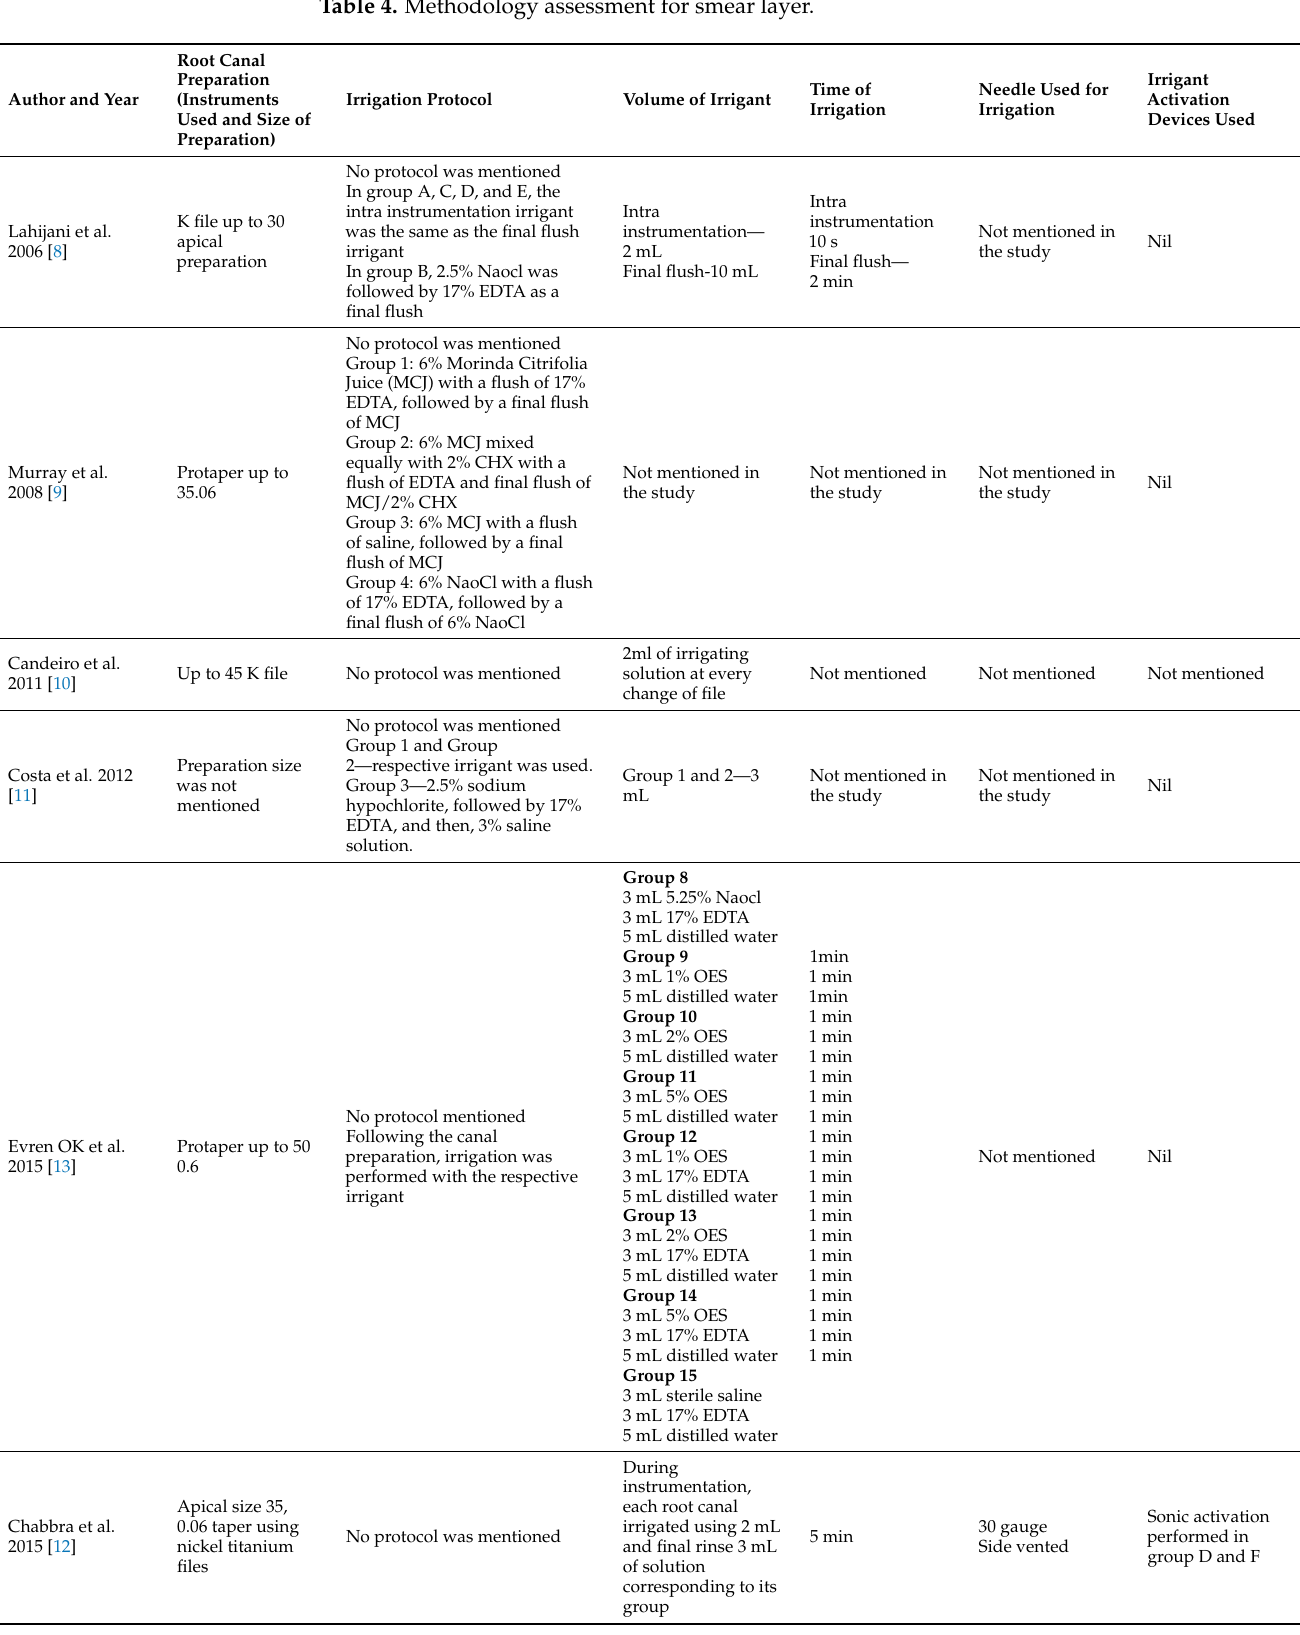
Table 4. Methodology assessment for smear